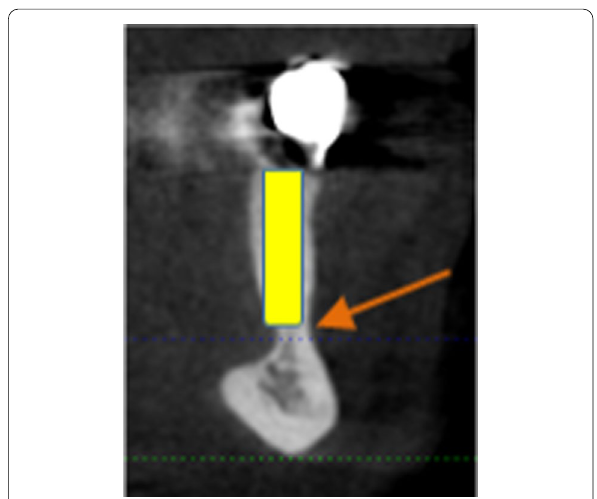
Fig. 3 CBCT with virtually planned implant planning in region 35 showing a funnel‑shaped contour of the jaw and a pronounced retraction of the jaw contour from the lingual side. The funnel‑shaped jaw contour is invisible in the panoramic radiography. Perforation of the jaw can be prevented through CBCT images